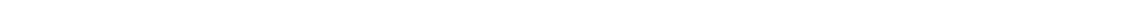
Fig. 2 2100 compound small-molecule screening in isogenic models of dysregulated dynamics uncovers differential drug sensitivities. a Immunoblot of OPA1, Drp1, or a loading control in TYKNU cells transduced with a control CRISPR or three independent sgRNAs targeting either OPA1 or DNM1L . Immunoblots are cropped for clarity. Immunoblot is representative of three independent experiments. b Schematic of the small-molecule screening method. c Left, snake plot depicting the log 2 (sgOPA1/sgCTRLA1) cellular viability ratio across 2100 compounds at two doses per compound. Right, snake plot depicting the log 2 (sgDNM1L/sgCTRLA1) cellular viability ratio across 2100 compounds at two doses per compound. Blue indicates a sensitivity, red indicates a resistance. d A count of the number of hits in each of the conditions listed. e A plot showing the log 2 (sgOPA1/sgCTRLA1) vs. the log 2 (sgDNM1L/sgCTRLA1) cellular viability ratios across three classes of drugs involving autophagy, transmembrane transporters, and apoptosis. Red indicates a compound that passes the hit-calling threshold for at least one knockout derivative. f A plot showing the log 2 (sgOPA1/sgCTRLA1) vs. the log 2 (sgDNM1L/sgCTRLA1) cellular viability ratios for drugs targeting nucleotide metabolism. Red indicates drugs that target purine metabolism and blue indicates drugs that target pyrimidine metabolism. g A boxplot showing the log 2 (knockout/control) cellular viability ratio for drugs that target guanine vs. those that target adenine. Data are mean ± SEM. * p < 0.05 by one-way ANOVA. h The log 2 (mDivi-1 25 μ M/vehicle) GI 50 for purine targeting drugs guanosine, penciclovir, adefovir dipivoxil, or pyrimidine targeting drugs, gemcitabine or 5-FU. Data are mean ± SEM. * p < 0.05 by one-way ANOVA. i GI 50 curves for guanosine, adefovir dipivoxil, and gemcitabine in TYKNU cells transduced with a control targeting sgRNA or three independent sgRNAs targeting either OPA1 or DNM1L ( n = 3). Data are mean ± SEM. * p < 0.05 by one-way